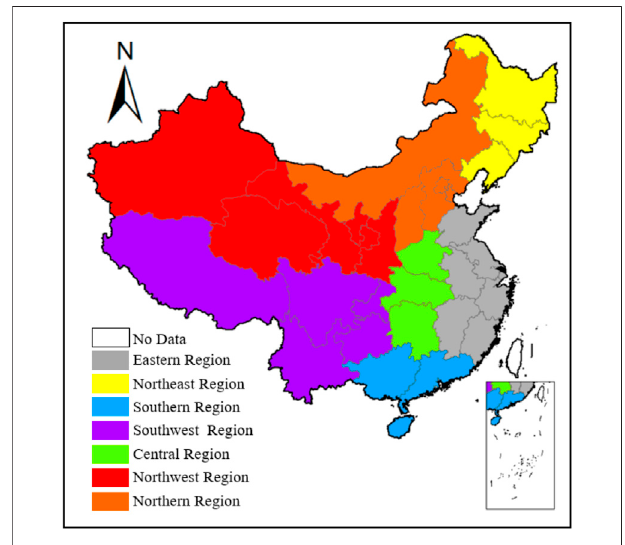
FIGURE 1 | Regions covered by fi re